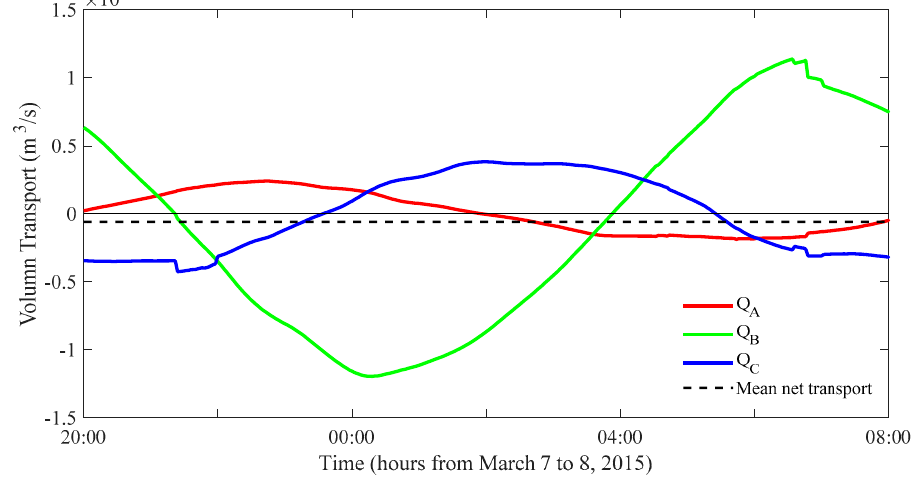
Figure 8. Volume transport variations for Q A (red line), Q B (green line), and Q C (blue line) during half day from 20:00 on 7 March to 08:00 on 8 March 2015. The dashed line indicates the 12-h average, ∆ Q